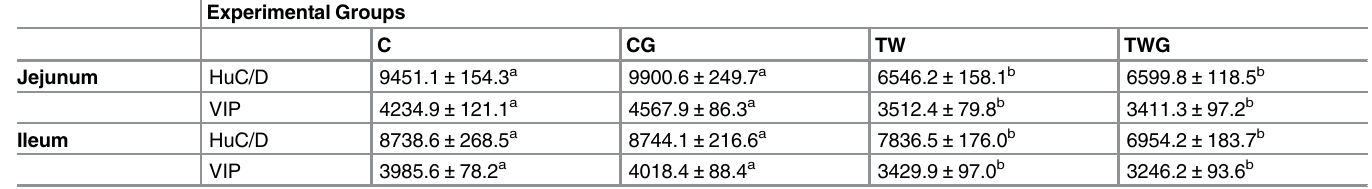
The results are expressed as mean ± SEM (n =